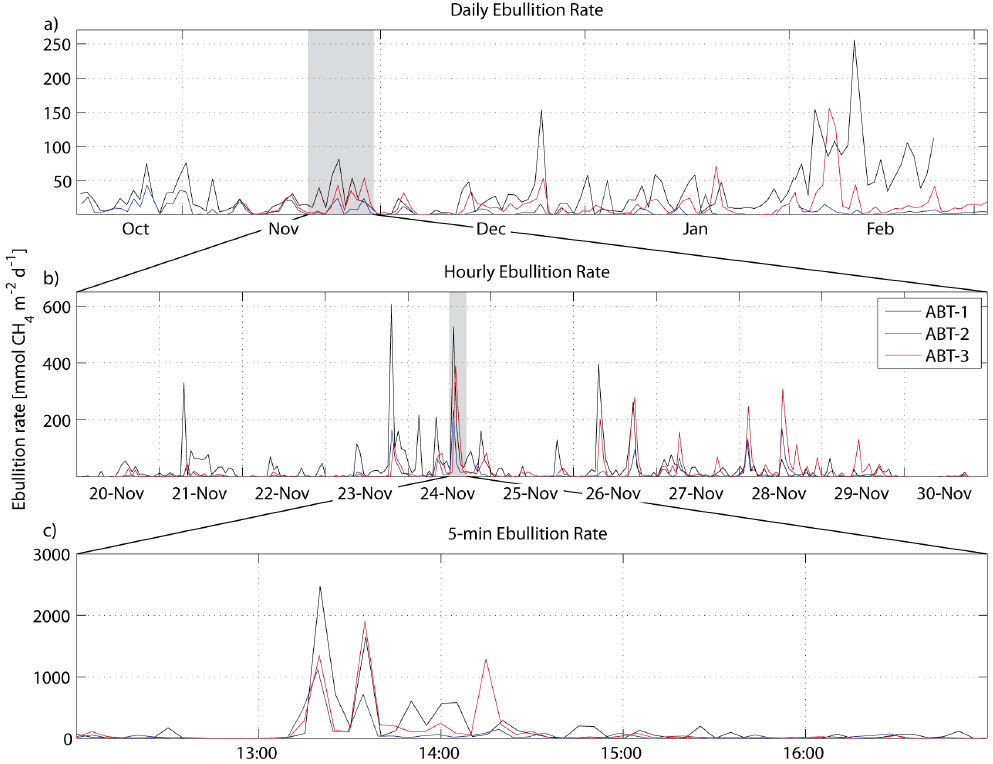
Fig. 5: Temporal variability of ebullition rates observed using the three automated bubble traps (ABTs) at different timescales: (a) Daily mean ebullition rates for the entire sampling period. (b) Hourly mean and (c) 5min mean ebullition rates for selected time periods indicated by the grey bars in (a) and (b). Table 2. Ebullition rates in mmolm − 2 d − 1 . All ebullition rates are shown as the median and 25th and 75th percentiles (in brackets). The day- and night-time ebullition rates refer to the hourly measured ebullition rates, while the daily ebullition rate is based on the daily ebullition rate. The N , p values and z values represent the results of a Wilcoxon test comparing day- and night-time ebullition